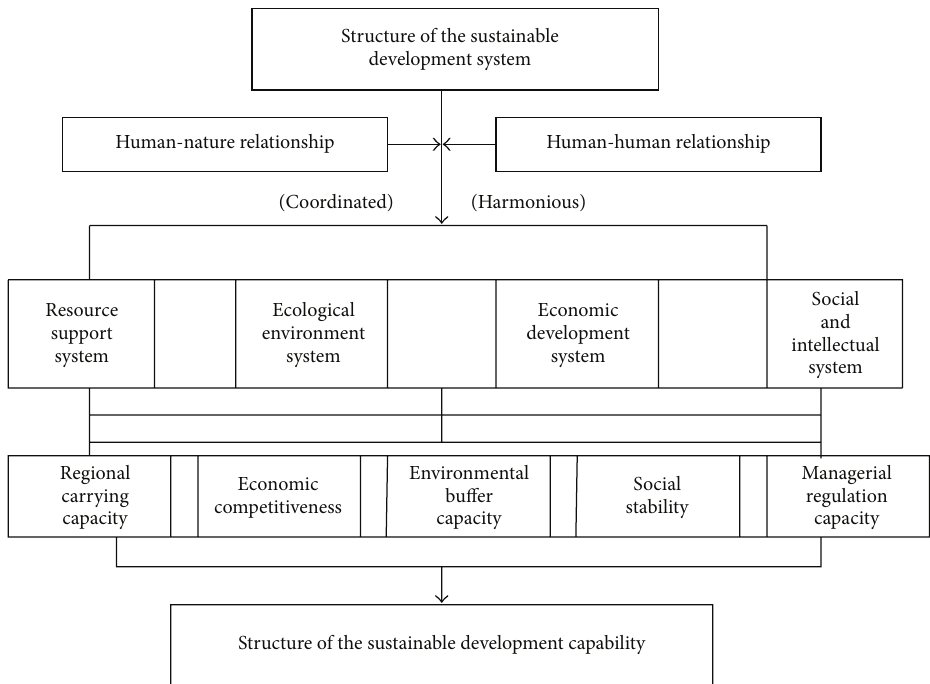
Figure 1: The framework of the sustainable development evaluation